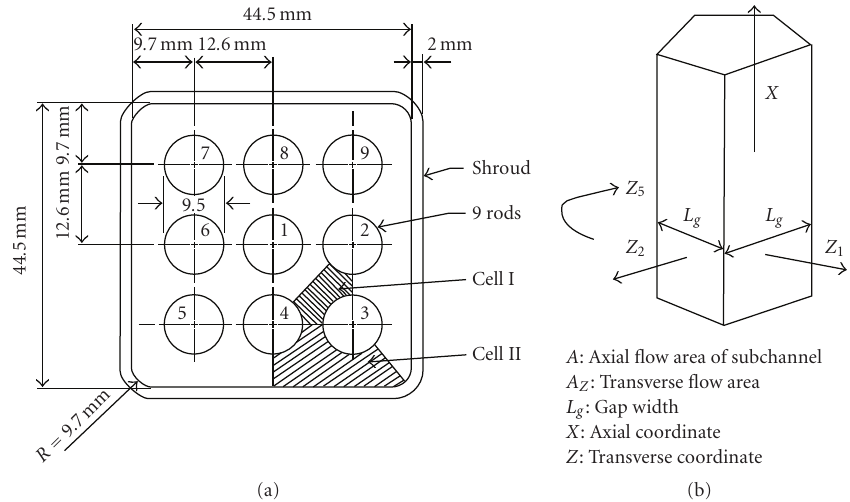
Figure 2: WCOBRA/TRAC subchannel formulation.